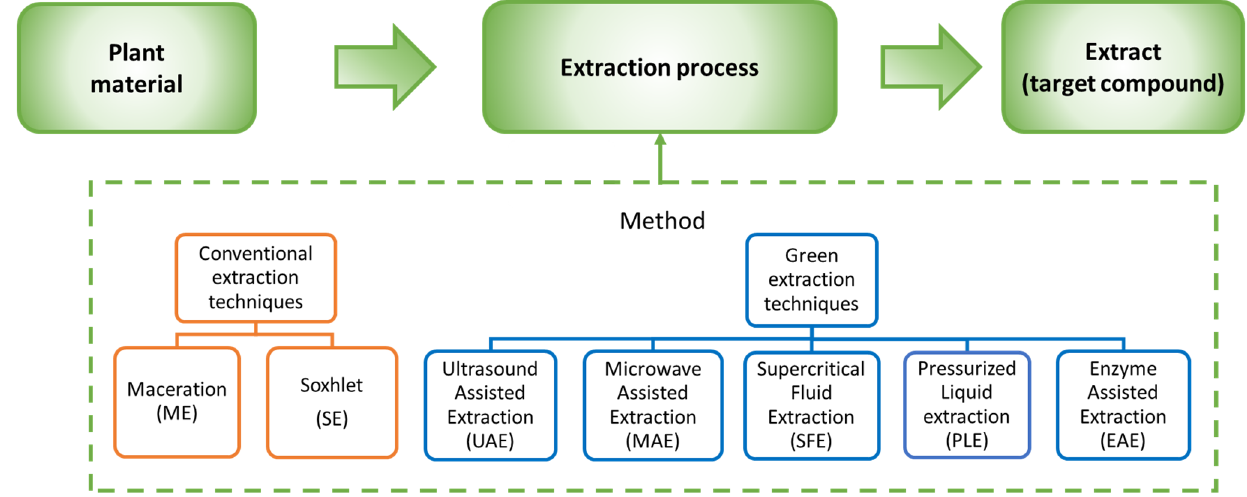
Figure 2. Simplified scheme of the extraction techniques employed to obtain target compounds from natural matrices.